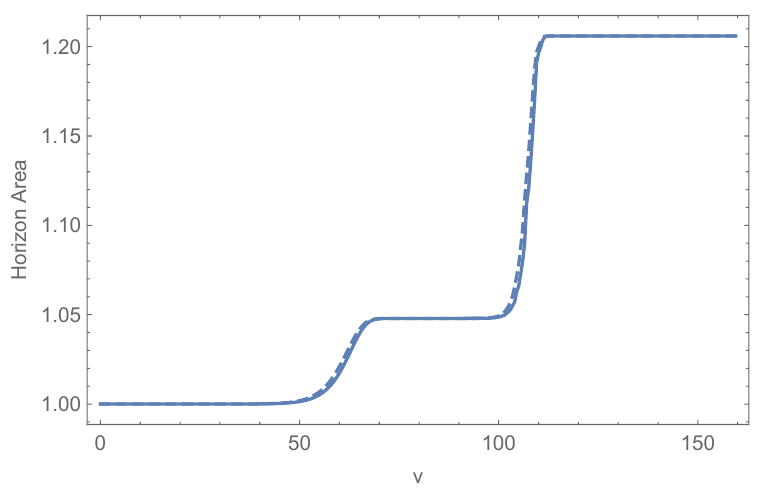
Figure 4 . The time evolutions of the areas of event horizon (dashed line) and apparent horizon (solid line) for Q = 2 and q = 6 . 5 . The excited state of holographic superconductor occurs at the first plateau.